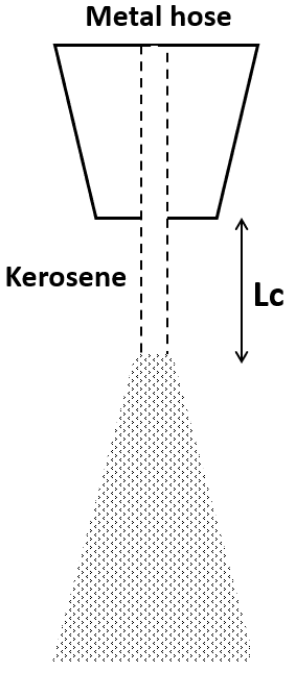
Figure 4. Kerosene atomization. Figure 4. Kerosene Table 2. Parameters of the metal hose.